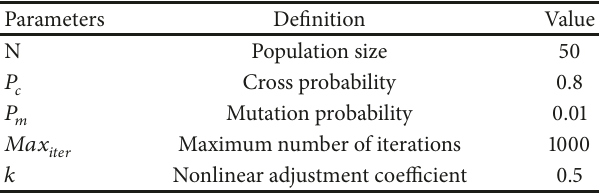
Table 3: Parameter settings of the